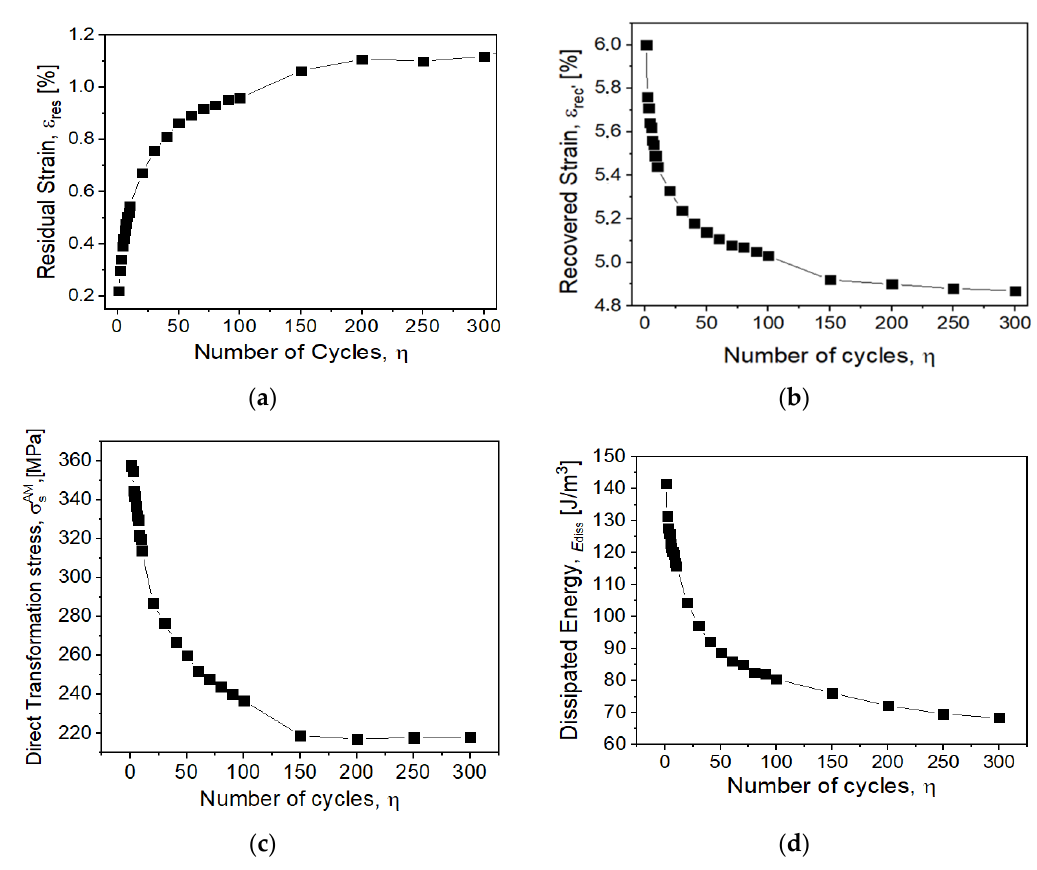
Figure 3. Mechanical behavior of NiTi wire. ( a ) Residual strain; ( b ) recovered strain; ( c ) direct transformation stress and ( d ) dissipated energy versus function of the number of cycles.